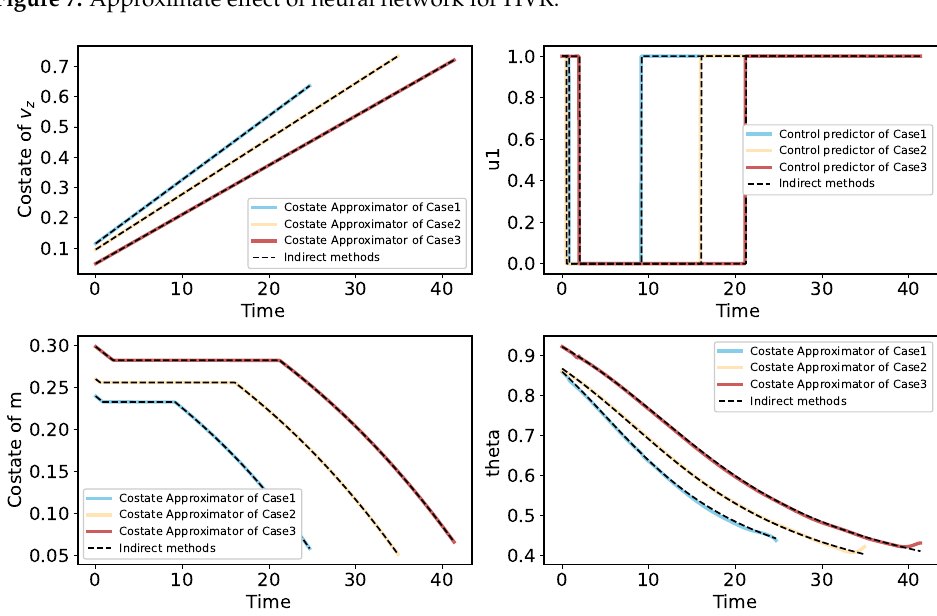
Figure 7. Approximate effect of neural network for HVR.